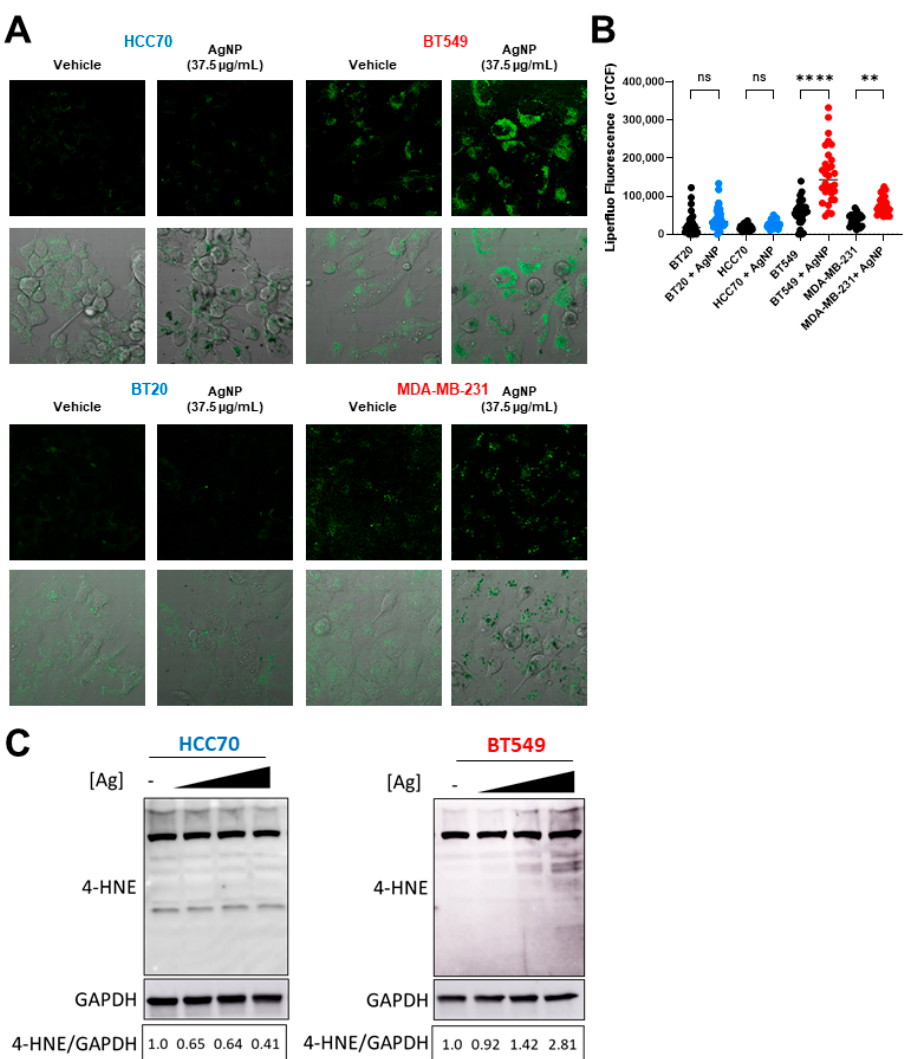
Figure 4. AgNPs induce lipid peroxidation and 4-HNE adduct formation in CLBC but not BLBC. To assess lipid peroxidation, BLBC (blue) and CLBC (red) cells were treated with AgNPs for 24 h, stained with Liperfluo, and fluorescence assessed by confocal microscopy ( A , B ). ( A ) Microscopy results shown are representative images from three independent experiments with at least three random fields assessed per sample. ( B ) Fluorescence intensity was quantified in at least 10 cells per field and statistical analysis was performed by one-way ANOVA followed by post hoc Tukey test. Significant differences are indicated (** p < 0.01; **** p < 0.0001). ( C ) 4-Hydroxynonenal (4-HNE) was assessed by Western blot in cells treated with (left to right) 0, 18.75, 37.5, or 75 µ g/mL AgNPs for 24 h. Densitometry was performed and the ratio of 4-HNE to GAPDH was calculated as indicated. The results are representative duplicate independent